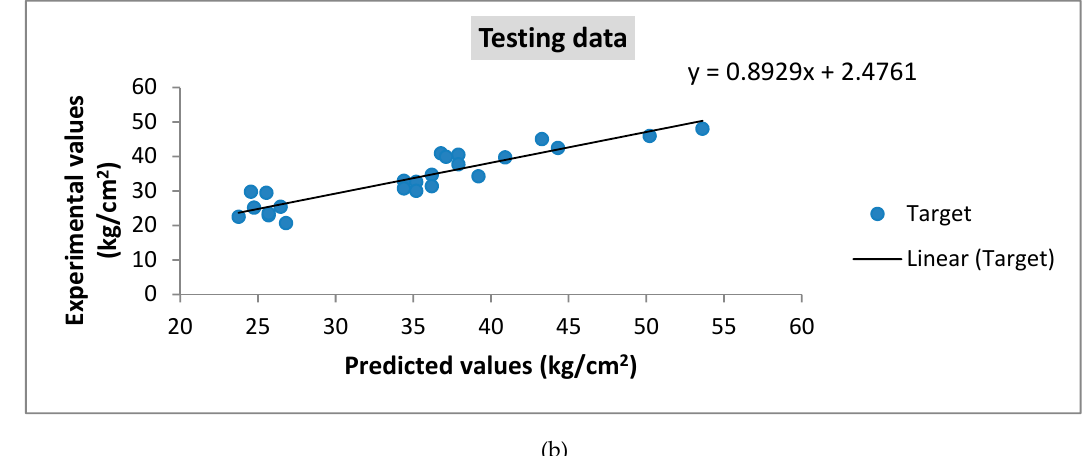
Figure 15. Regression chart for the GEP1 prediction model of tensile strength: ( a ) training, ( b ) testing data.